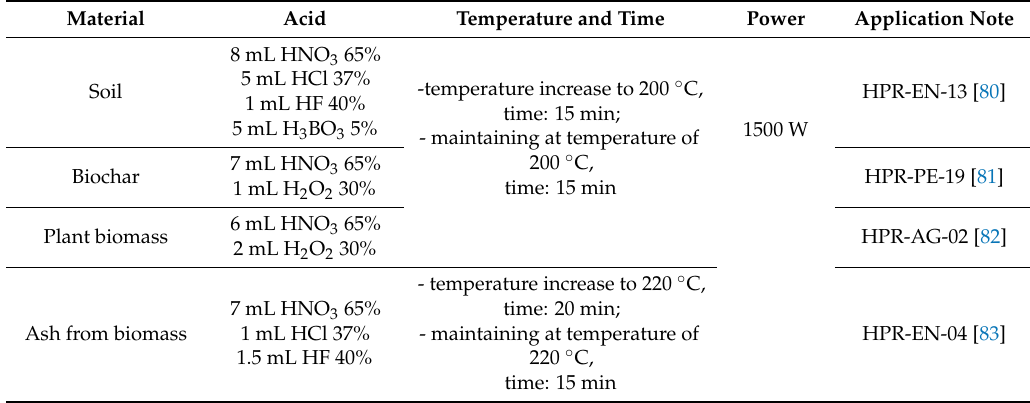
Table 8. Parameters of the mineralisation